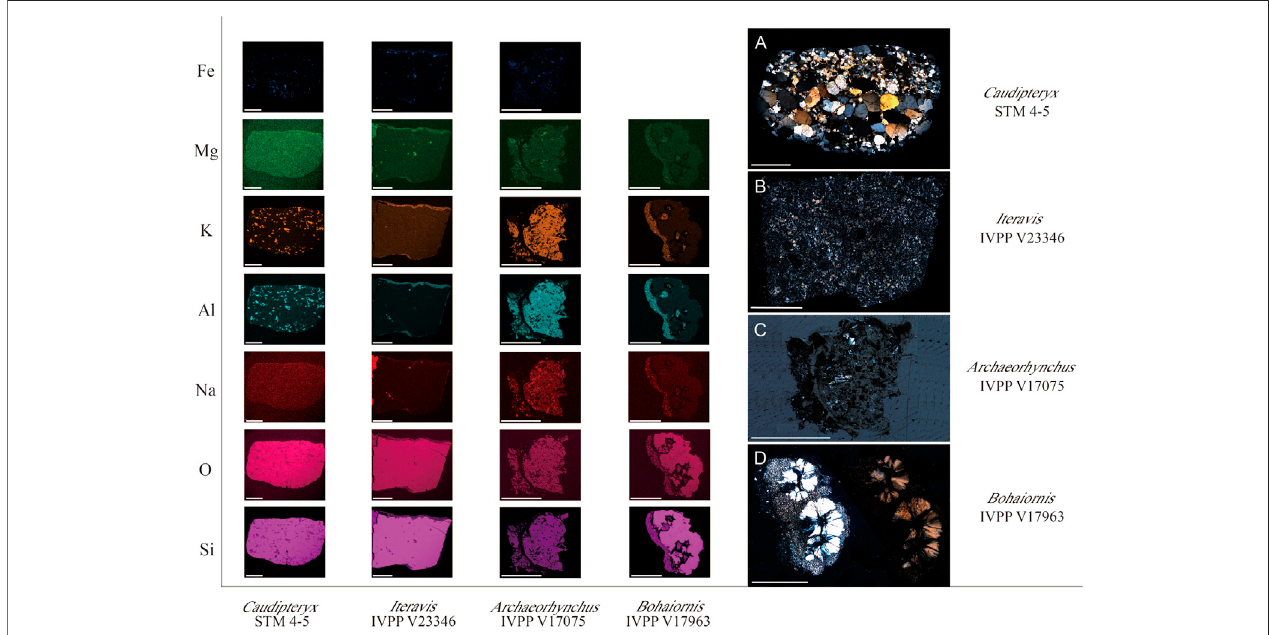
FIGURE5| EDSelementmappingandground-sectioningslidesoffourextractedgastrolithsamples.Photographsontherightsidearegroundsectionsofsamples under polarized microscope. Scale bar equals 1 mm.